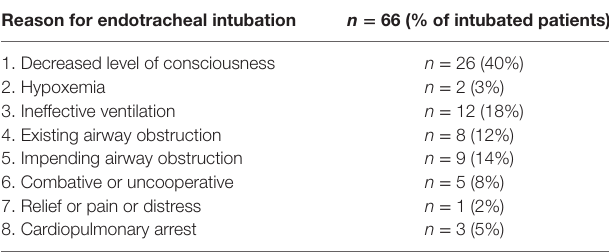
TaBle 5 | Reason for prehospital endotracheal intubation.